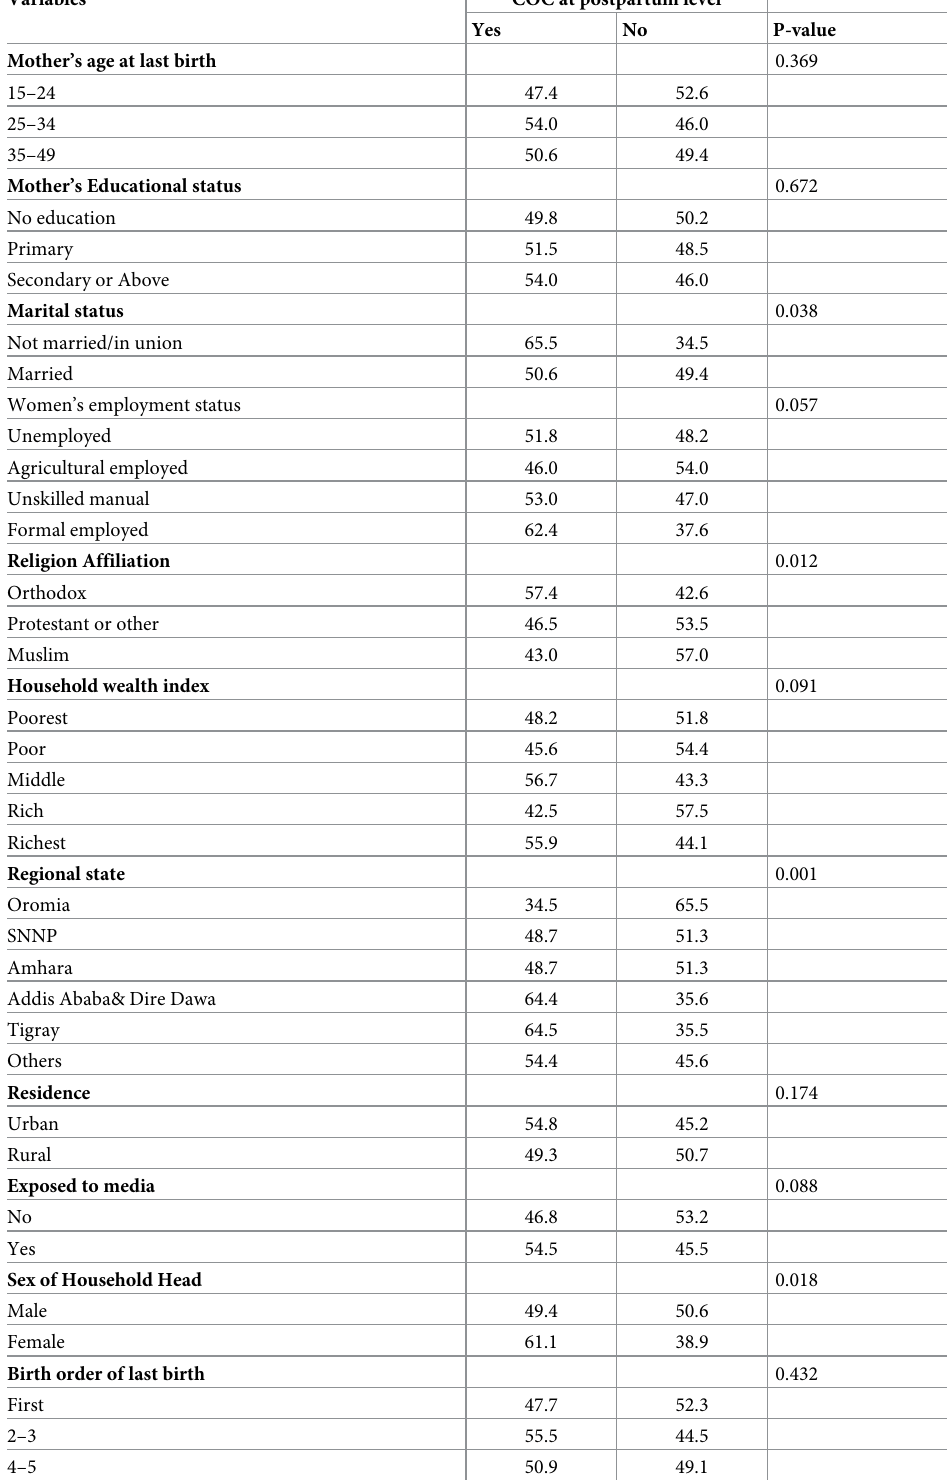
Table 3. Distribution of Completion CoC at the postpartum level by explanatory variables (N =